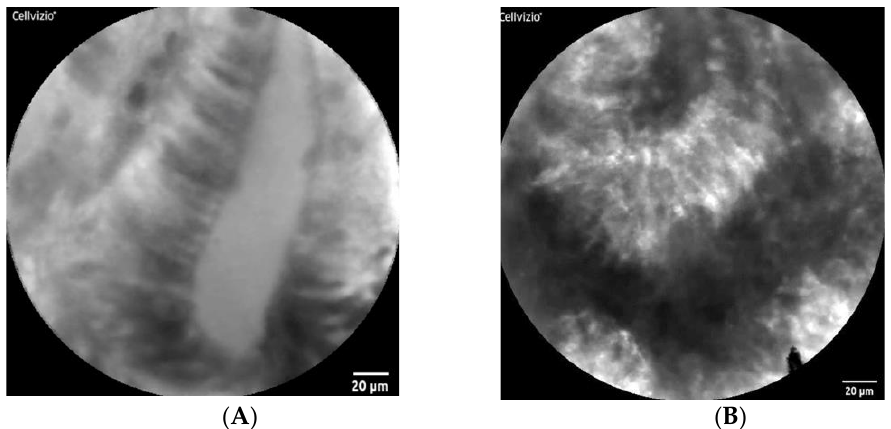
Figure 3. Representative images of pCLE with no administration of tracers. ( A ): Normal epithelium: regular arrangement of epithelial cells with circular nucleus around organized crypt/gland. ( B ): EAC: irregular arrangement of epithelial cells with irregular-shaped nucleus.